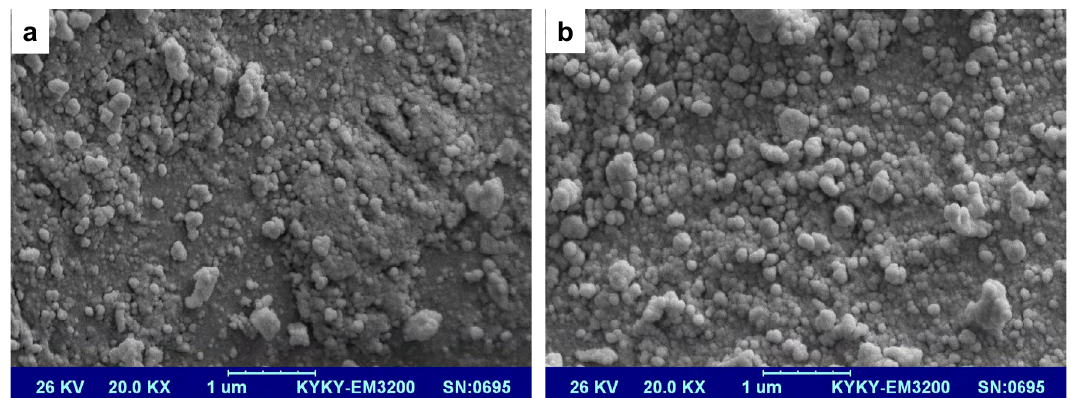
Fig. 3. SEM image of samples. (a) TiO2; (b)